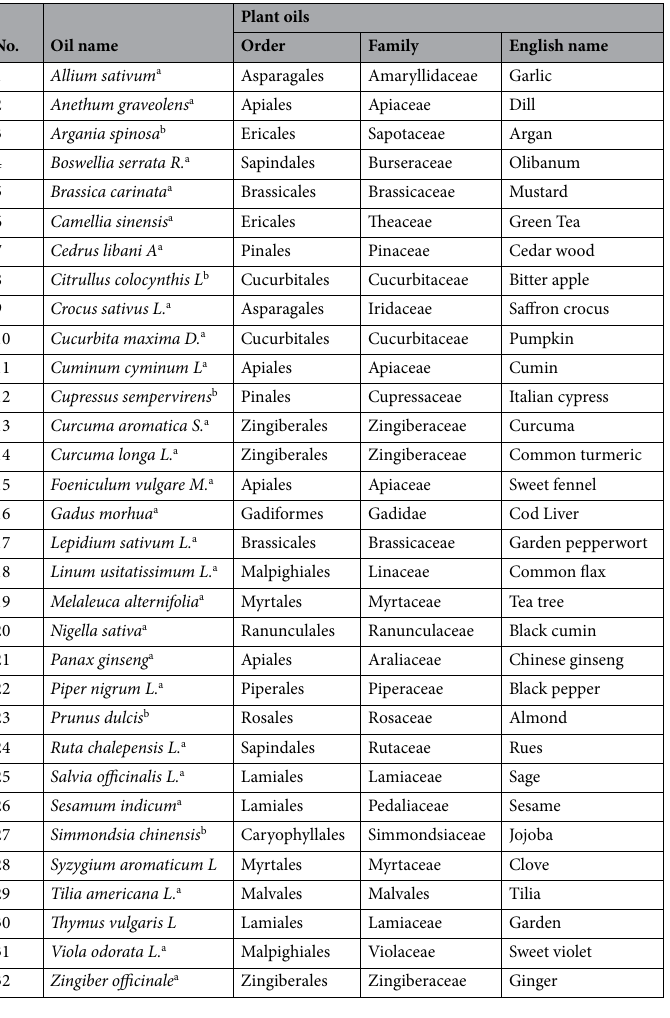
Table 1. Plants species screened (oil No = 32) used for larvicidal activity. a Plant oils purchased from EL CAPTAIN company for extracting natural oils, plants and cosmetics “Cap Pharm”. b Plant oils purchased from Harraz for Food Industry & Natural